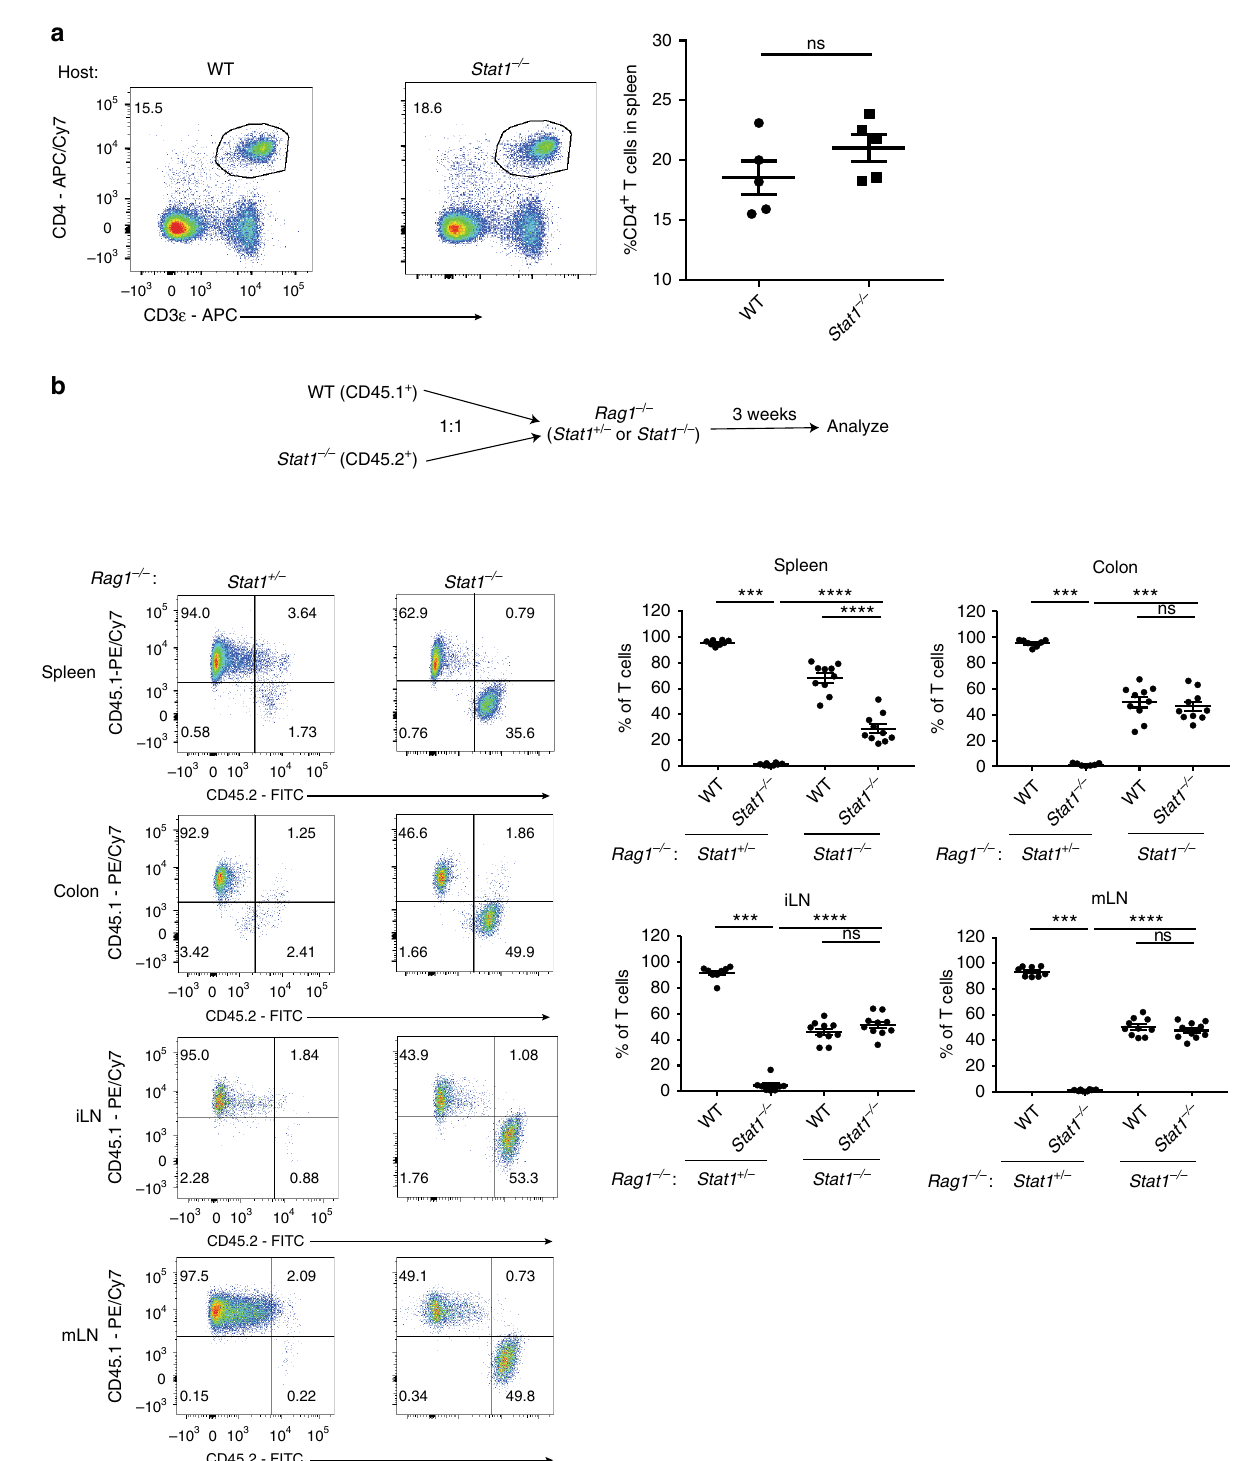
Fig. 8 Innate STAT1 expression is required to eliminate Stat1 − / − T cells. a Representative fl ow cytometry plots of CD4 + T cells in the spleen of WT and Stat1 − / − mice followed by their mean frequencies ± SEM. b WT (CD45.1 + ) or Stat1 − / − (CD45.2 + ) CD4 + T cells were injected i.p. at a 1:1 ratio (1 × 10 6 / type) into Stat1 − / − Rag1 − / − mice or their Stat1 + / − Rag1 − / − littermate controls and analyzed after 3 weeks. Representative images of CD45.1 + vs CD45.2 + cells (gated on live CD45 + CD3 ε + CD4 + T cells) from various organs are shown followed by their mean frequencies ± SEM. Pooled from three independent experiments, with each point representing an individual mouse. *** p < 0.001, **** p < 0.0001 by two-tailed Mann – Whitney